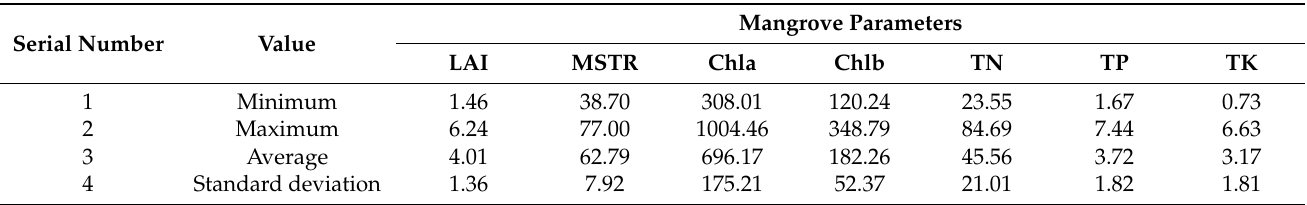
Table 1. Statistics of the contents of seven mangrove parameters in each leaf sample obtained after in situ detection. The dimensions of each leaf sample were 0.2 m × 0.2 m. The weight is 0.2 kg, which is enough for mangrove parameter analysis and